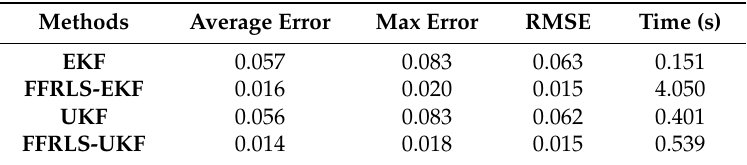
Table 3. Comparison of Algorithms with measurement